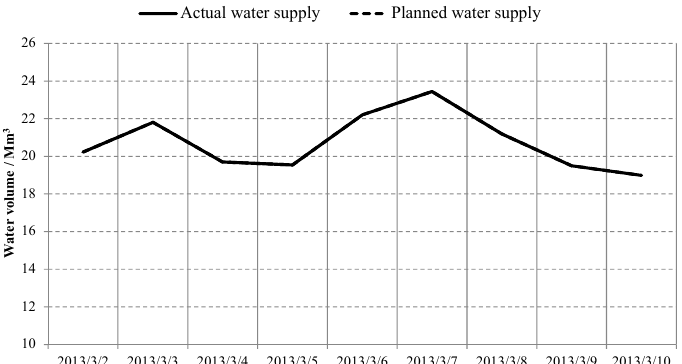
Figure 13. The water flow process of the Changliubi waterworks during the operation period.